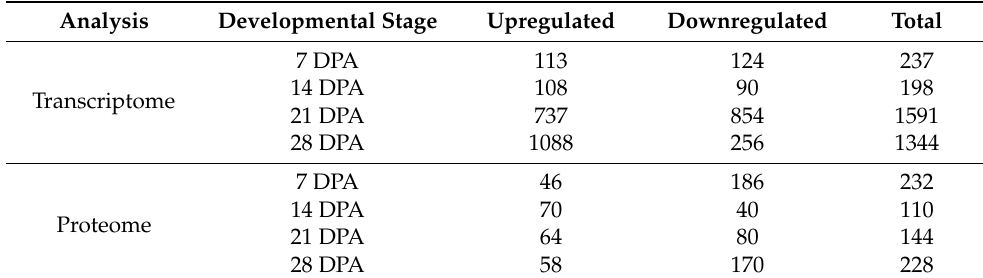
Table 1. Summary of differentially expressed genes and proteins between the transgenic and non- transgenic line at four